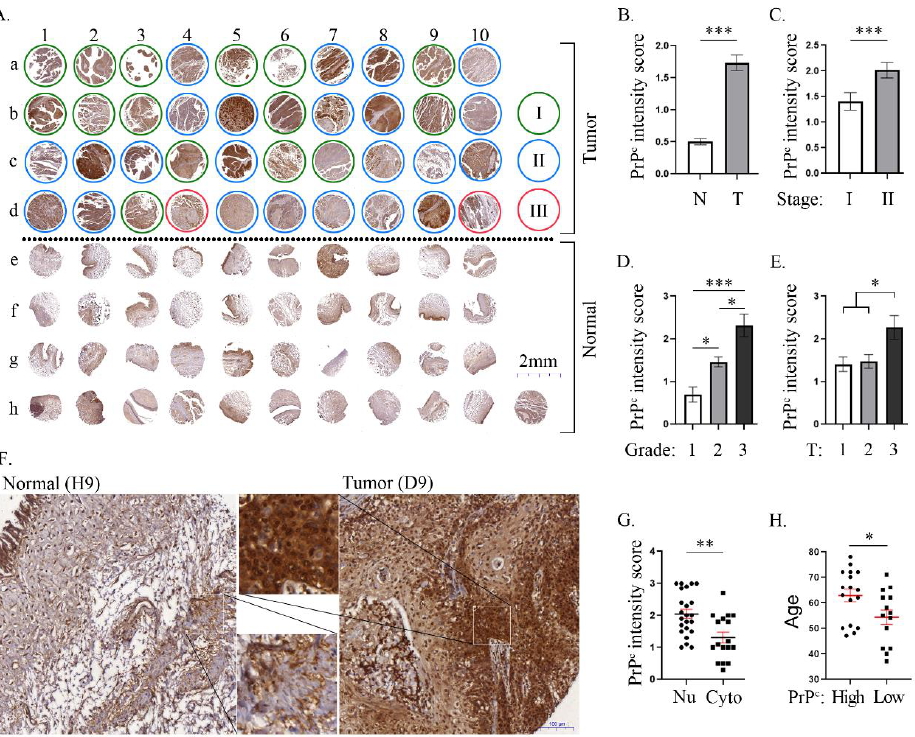
Figure 1. The cellular expression of PrP C in human bladder cancer patients. ( A ) Immunohisto- chemical results of cellular prion protein (PrP C ) on bladder cancer (BC) tissue arrays from 38 BC patients. Columns a to d represented harvested BC tissue; e to f represented normal specimens (i.e., normal part of BC), i.e., indicating that (a) represented a BC specimen and (d) corresponded to a normal specimen from the same BC patient. The green, blue, and red circles represent Stage I, II, and III classifications (i.e., TNM staging system), respectively. ( B ) The expression of PrP C in the tumor part was remarkably increased when compared to the normal part from the same